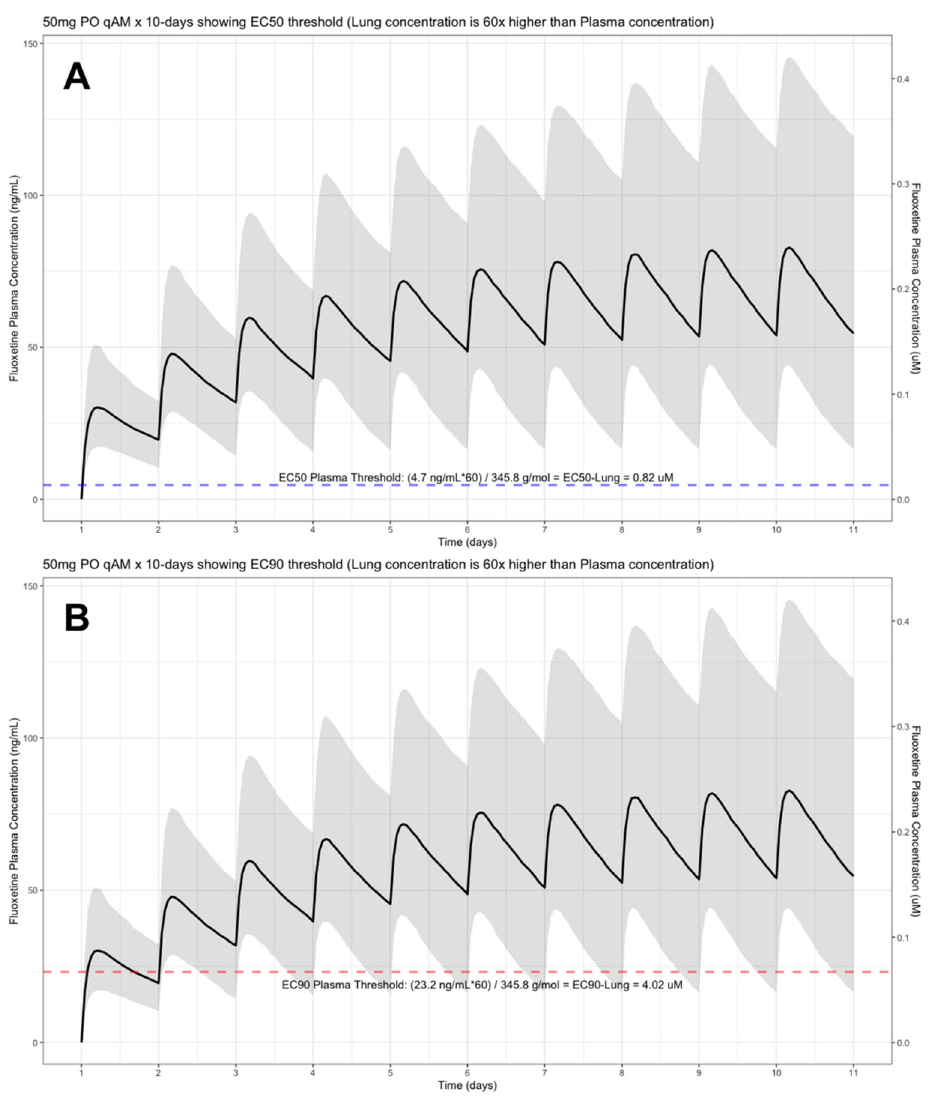
Figure 4. Fluoxetine population (n=1,000) dosing simulation results for an oral dose of 50 mg/day for 10 days. The shaded regions illustrate the 10th (lower) and 90th (upper) percentiles with the solid line within the shaded region representing the median fluoxetine concentration. The dashed horizontal line depicts the effective concen- tration resulting (A) 50% and (B) 90% inhibition (EC90) of SARS-CoV-2 that will result in 60-times higher level in the Overall, from a drug-safety perspective, prior to administering fluoxetine, a careful review of all current medications and clinical status by a physician clinical pharmacologist to avoid drug interactions due to fluoxetine ’ s ability to strongly inhibit CYP2C19 and CYP2D6 (Hefner, 2018). Compounds that are sensitive and moderate CYP2C19 substrates (e.g. omeprazole, diazepam, lansoprazole, rabeprazole, voriconazole) and CYP2D6 substrates (e.g. dextromethorphan, concentration-time curve of ≥ 5-fold drug exposure when treated with fluoxetine (https://www.fda.gov/drugs/drug- interactions-labeling/drug-development-and-drug-interactions-table-substrates-inhibitors-and-inducers). Lastly, patients who have a pharmacogenomic profile of being a CYP2D6 Ultra-rapid Metabolizers may have sub-therapeutic fluoxetine concentrations; while, CYP2D6 Poor Metabolizer or Intermediate Metabolizers may have supratherapeutic concentra- tions and should be monitored for potential fluoxetine side-effects; but may also have a higher rate of achieving the target trough EC90 concentration at a 20 mg/day fluoxetine dose relative to CYP2D6 Normal (Extensive) Metabolizers.